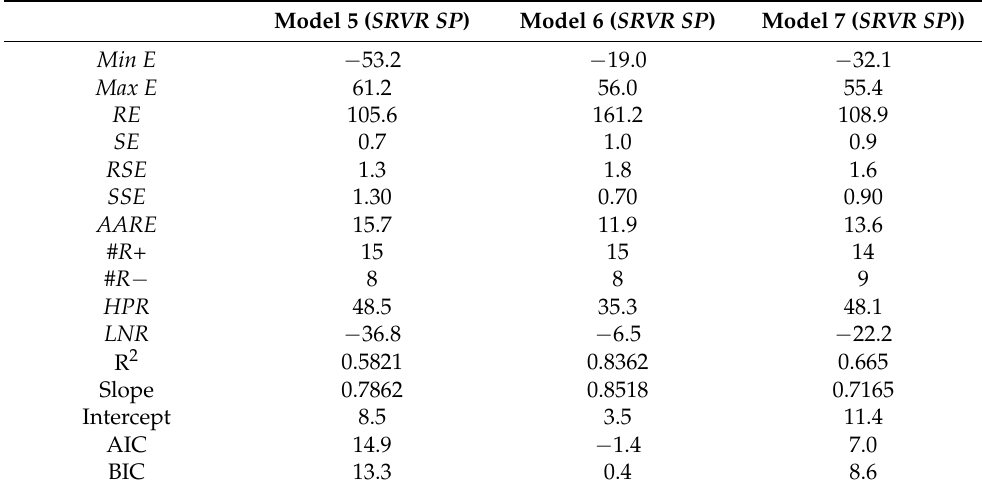
Table 13. Statistical analysis of the three SRVR softening-point